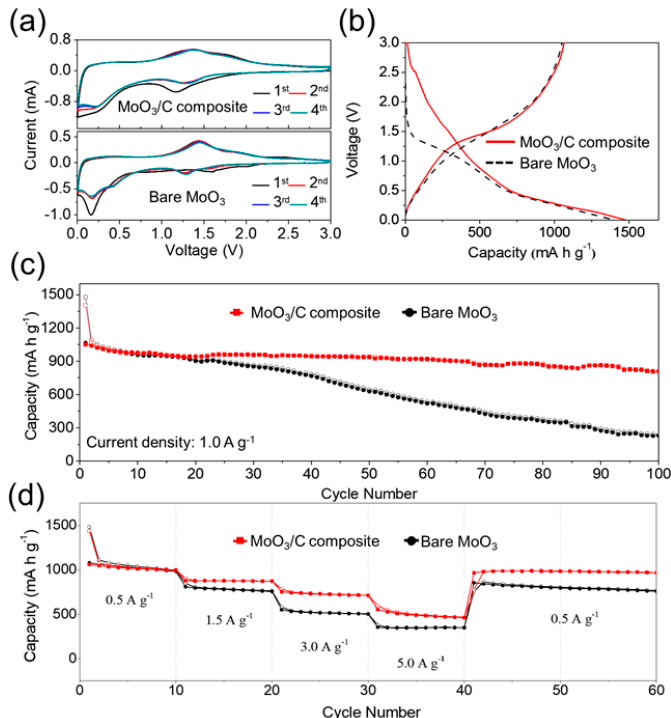
Figure 5. The electrochemical properties of the MoO 3 /C composite microspheres and the bare MoO 3 powders: ( a ) CV curves, ( b ) charge-discharge curves, ( c ) cycling performances, and ( d ) rate performances.